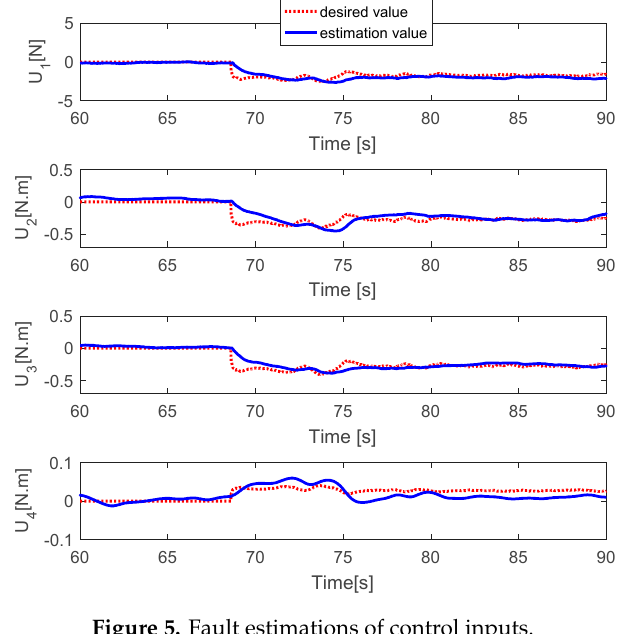
Figure 5. Fault estimations of control inputs.